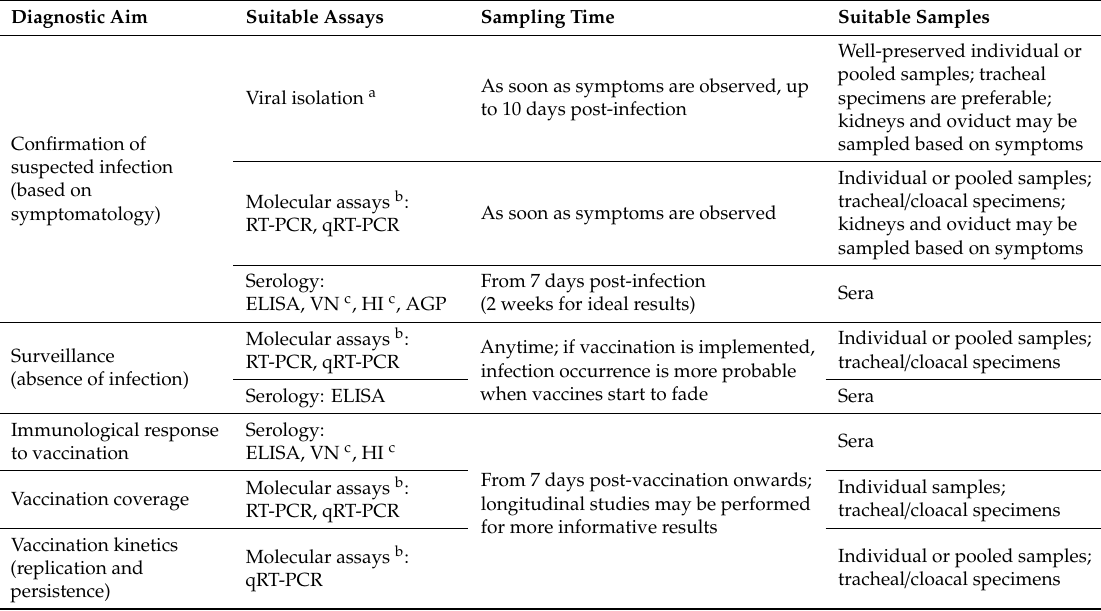
Table 1. Diagnostic guidelines describing the suitable procedures based on the intended